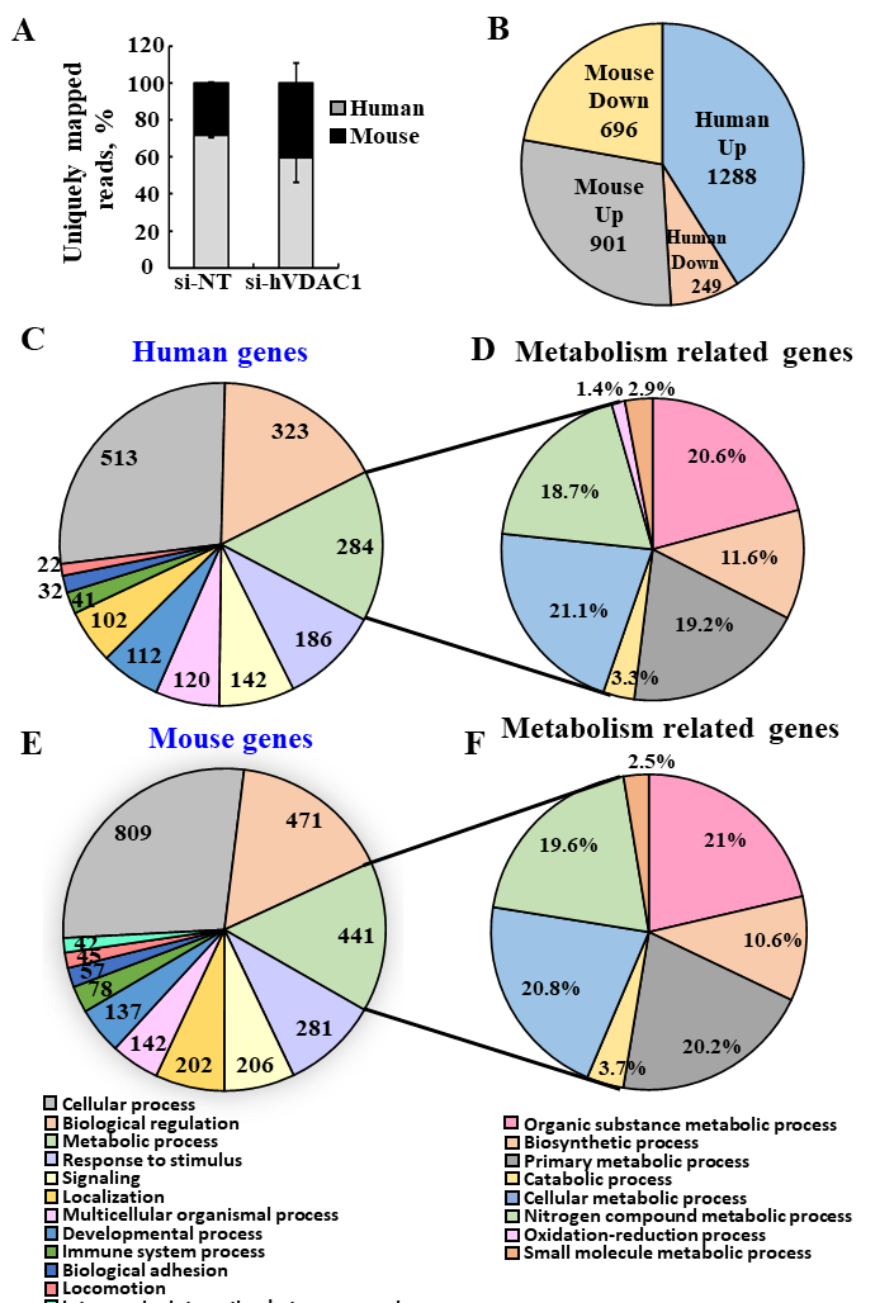
Figure 2. NGS gene analysis of mouse and human origin differentially expressed in si ‐ hVDAC1 ‐ 2A ‐ TTs. RNA, isolated from tumors treated with si ‐ hVDAC1 ‐ 2A or si ‐ NT (75 nM), was subjected